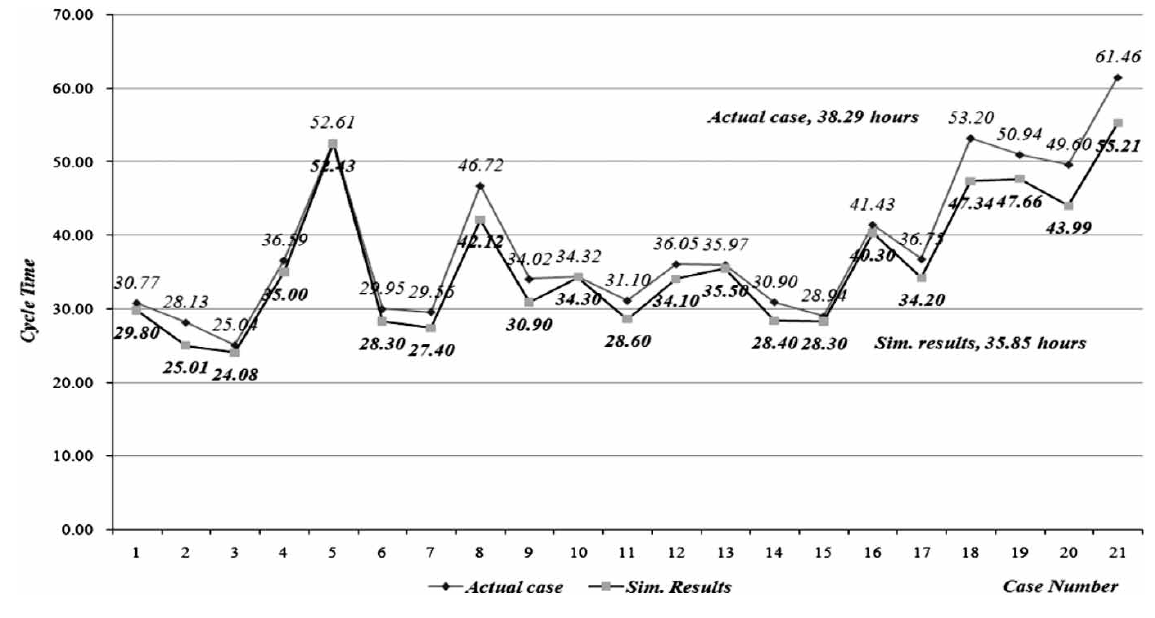
Fig. 6. Comparison between actual case and simulation result